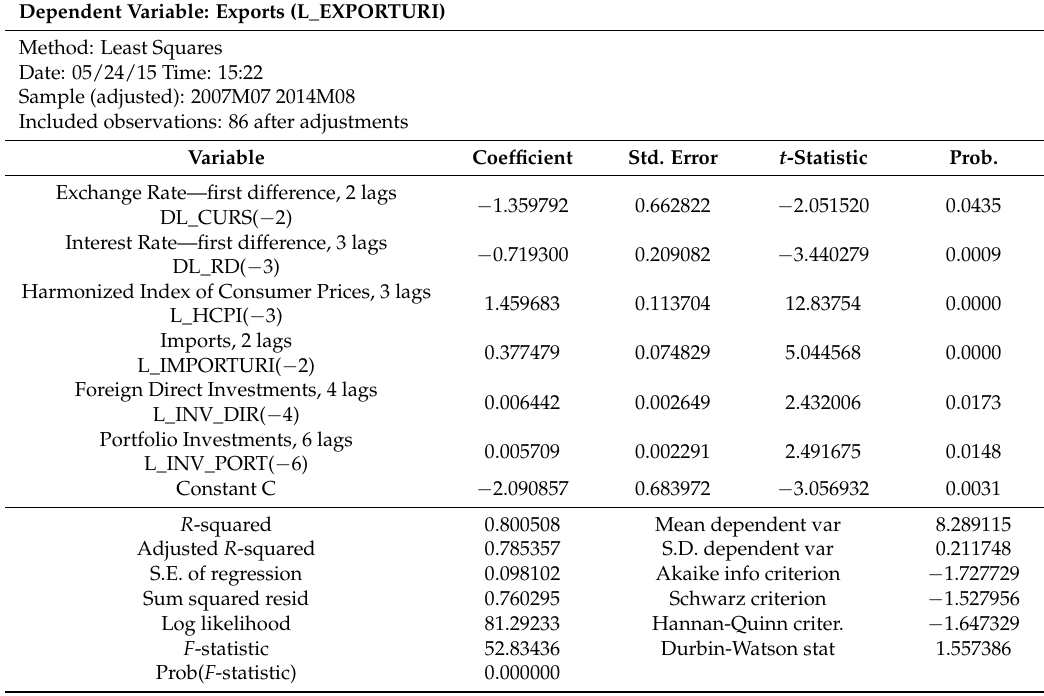
Table 2. Regression model—Exports as dependent